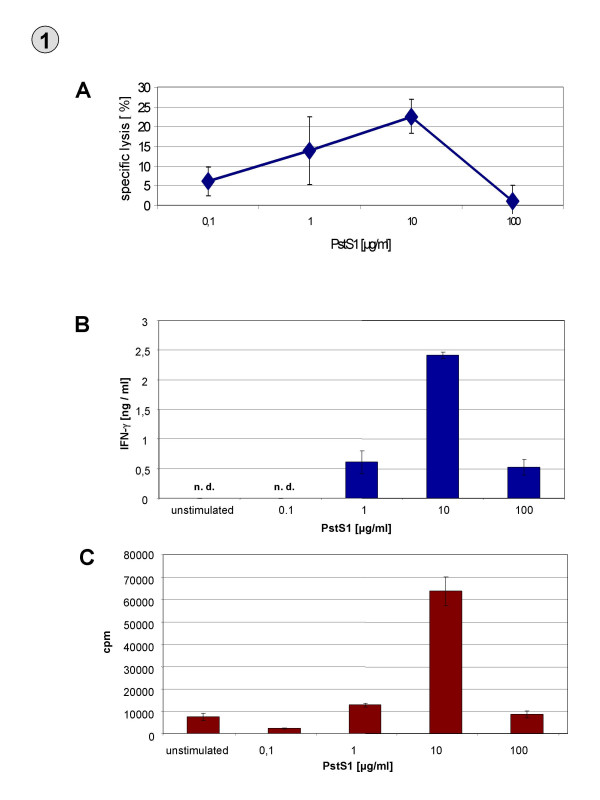
Activation of PBMC by PstS1 is dose-dependent. PBMCs were stimulated for 7 days with different PstS1 concentrations in a range from 0.1 μg/ml to 100 μg/ml. A 4-hour chromium release assay against T-24 bladder tumor cells. Effector-target cell ratio of 40:1 B IFN-γ release was determined by ELISA from supernatants of the stimulated PBMCs C PBMC proliferation was measured by overnight 3H-Thymidine incorporation assay (1 μCi/2 × 105 cells). One representative experiment out of 3–6 is shown (mean ± SD). n.d. = not detectable